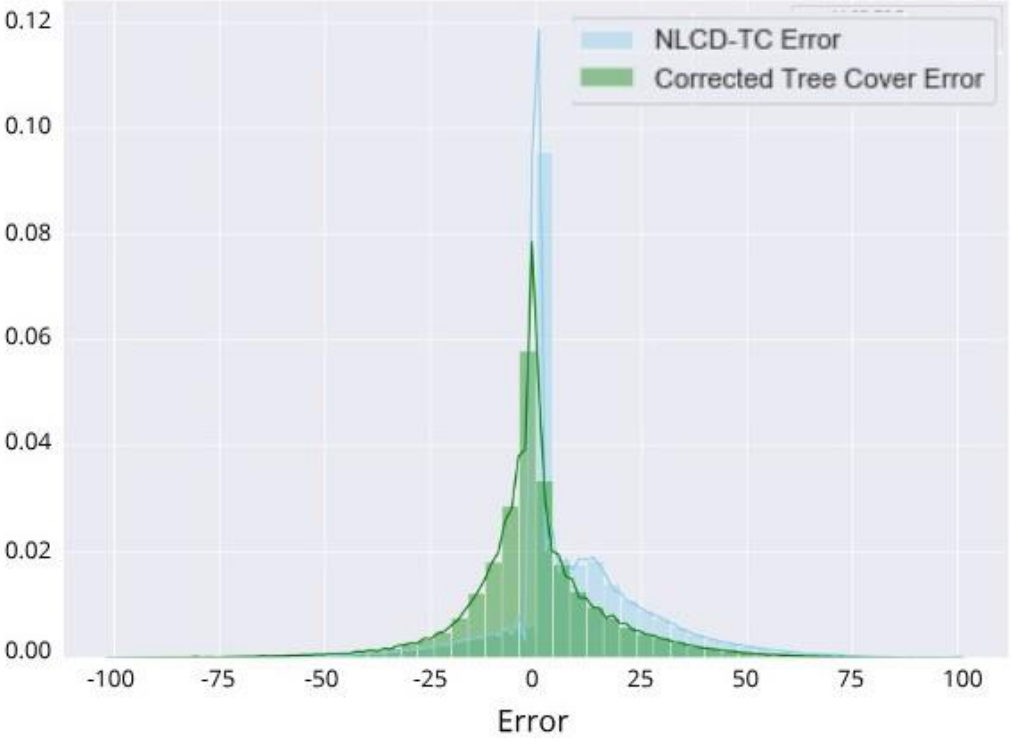
Figure 10. Comparison of National Land Cover Database-Tree Canopy (NLCD-TC) and corrected tree cover error (deviation by % when compared to high-resolution derived data) distribution; the smoothed lines are the normal density lines.